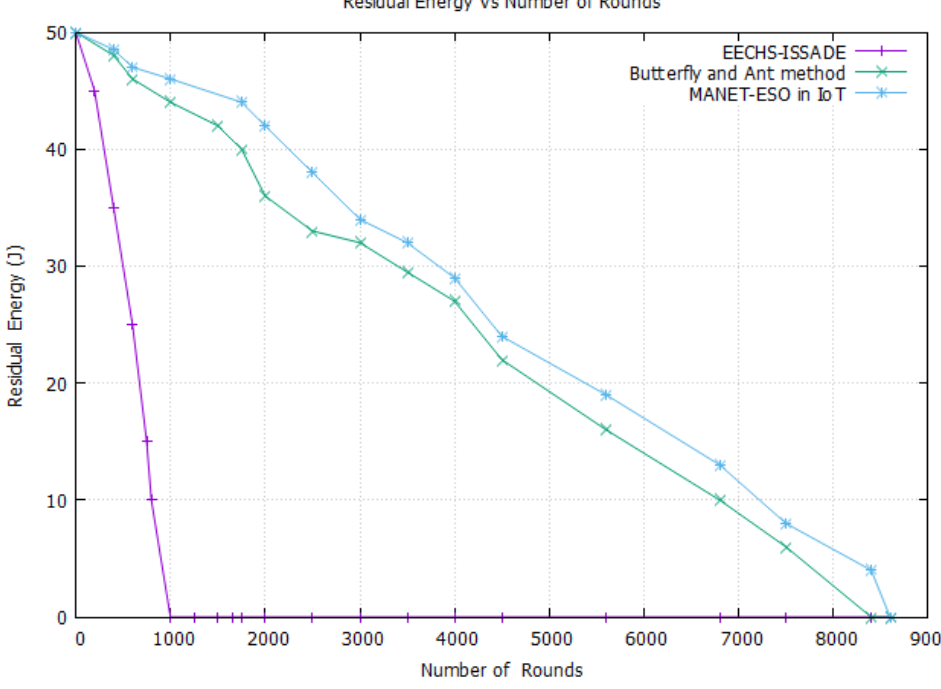
Figure 3. Residual Energy vs. number of rounds.